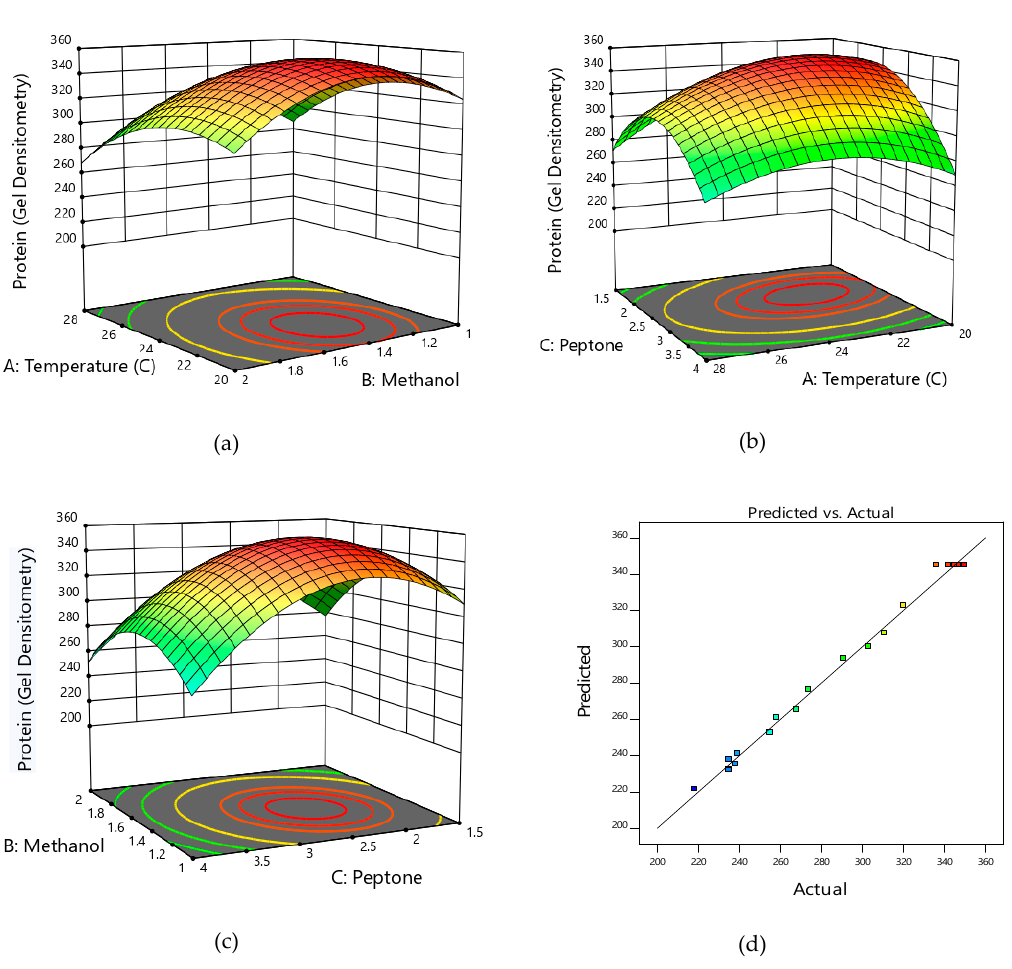
Figure 3. ( a ) Pareto chart obtained from the Plackett-Burman design representing the order and % contribution of each parameter on production of stable HSA. Blue and orange color represent the negative and positive contribution respectively. ( b ) Estimated effects of independent variables on HSA production by Clone # 14. Red indicate the most significant while blue indicate nonsignificant parameters.